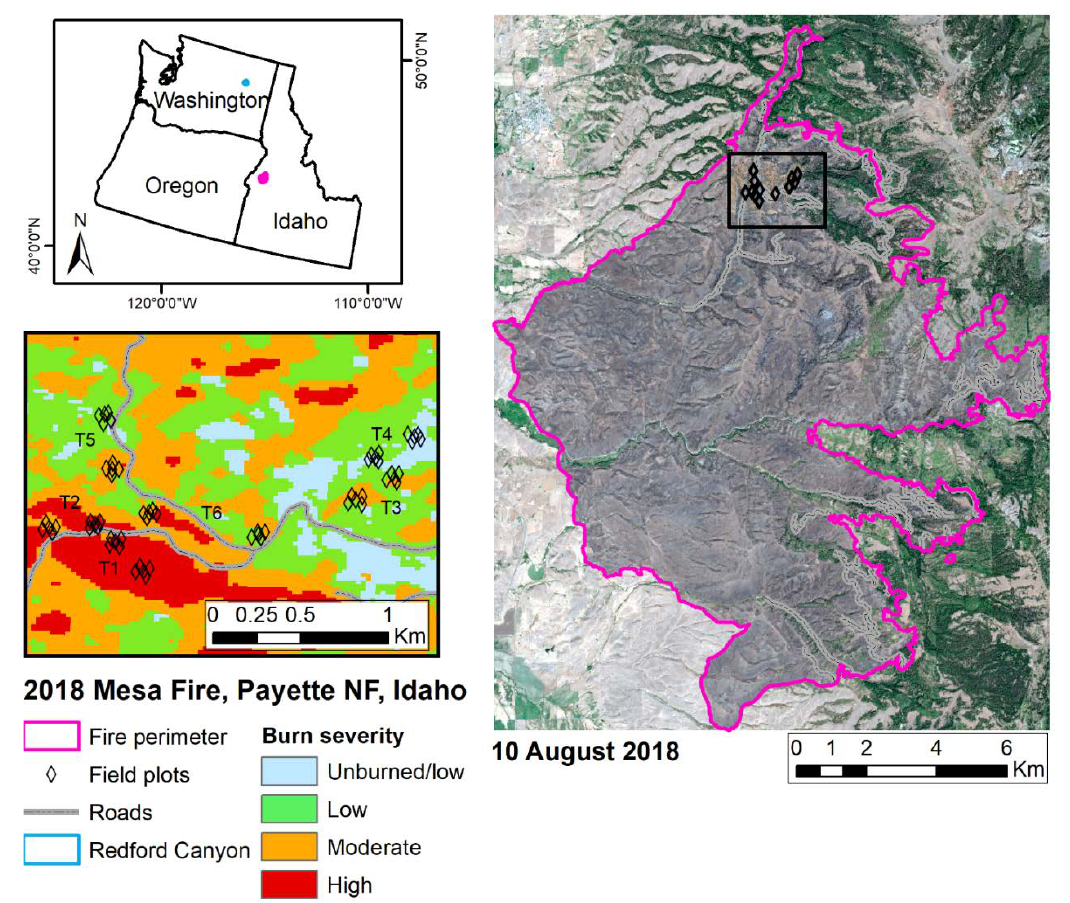
Figure 1. The locations of the Mesa (ID) and Redford Canyon (WA) fires. The satellite imagery is a Sentinel-2 true color image obtained shortly after the Mesa Fire was contained. The burn severity inset map shows the distribution of the Mesa field transects (T1–T6) with 5 radial plots at each endpoint.